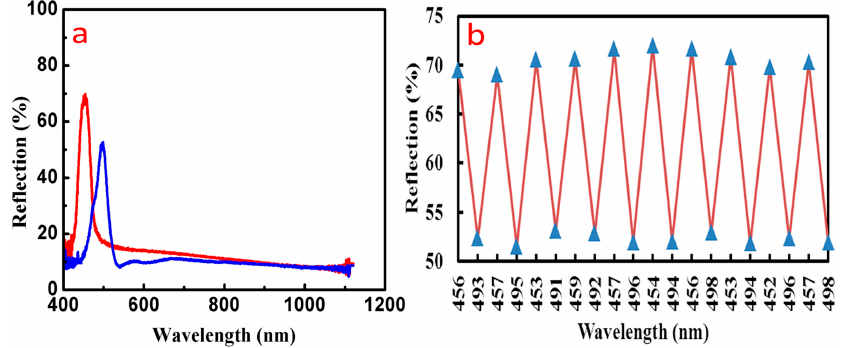
Figure 8. ( a ) Reflection spectrum of the inverse opal structure PCs before and after being filled with ethanol; ( b ) Spectral change of reflectivity and reflection wavelength after 10 ethanol-air cycles.